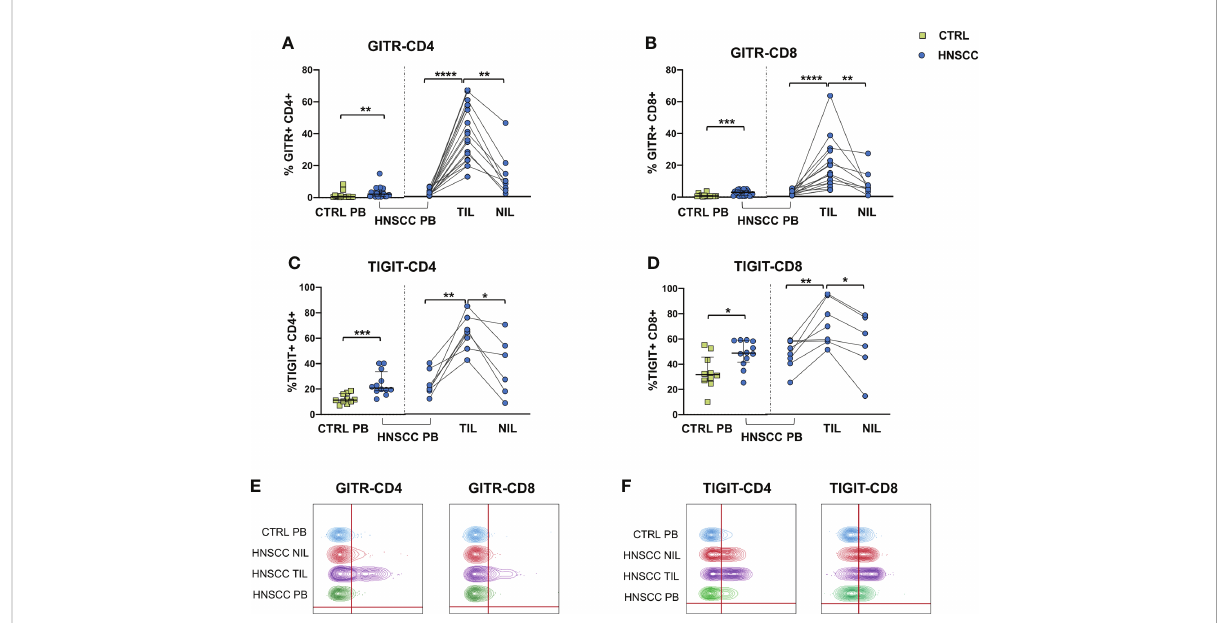
FIGURE 7 Expression of (A, B) the GITR costimulatory molecule and (C, D) of the TIGIT checkpoint molecule on CD4+ and CD8+ T cells. The Mann – Whitney U test was used to compare CTRL and HNSCC subjects. Paired data were analyzed by the Wilcoxon signed rank test. *p < 0.05, **p < 0.01, ***p < 0.001, ****p < 0.0001. (E) Representative concatenated fl ow cytometry plots showing the percentage of GITR-expressing CD4+ and CD8+ T cells. (F) Representative concatenated fl ow cytometry plots showing the percentage of TIGIT expression on CD4+ and CD8+ T